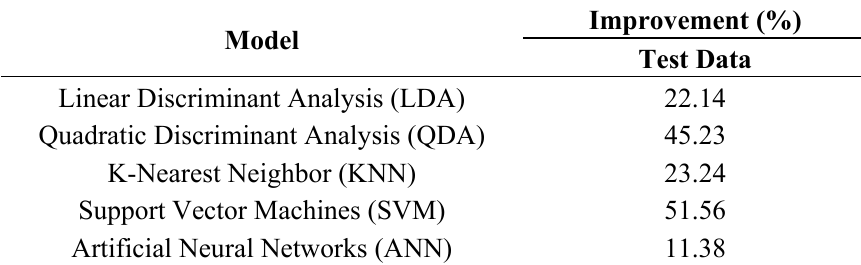
Table 3. Improvement of the proposed model in comparison with those of other classification